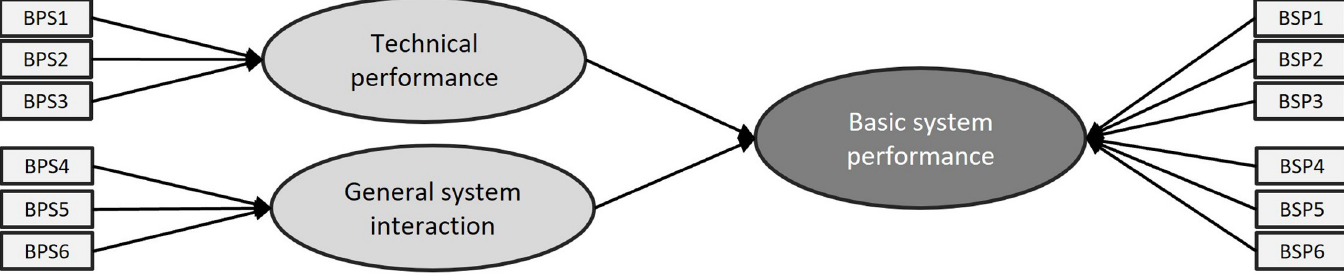
Fig 2. Formative Hierarchical Components Model (HCM) of the category ‘Basic System Performance’.